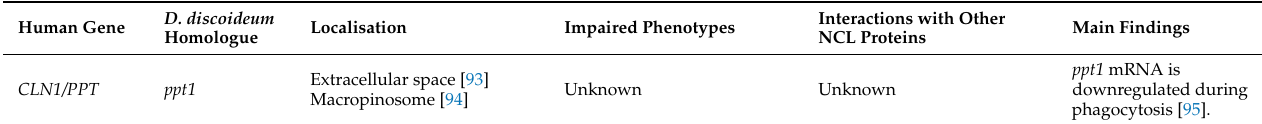
Table 2. Neuronal ceroid lipofuscinoses-associated genes studied in D. discoideum